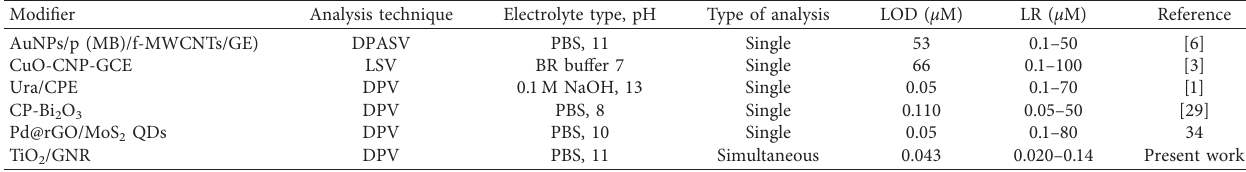
Table 3: A comparison of analysis results of nevirapine at TiO